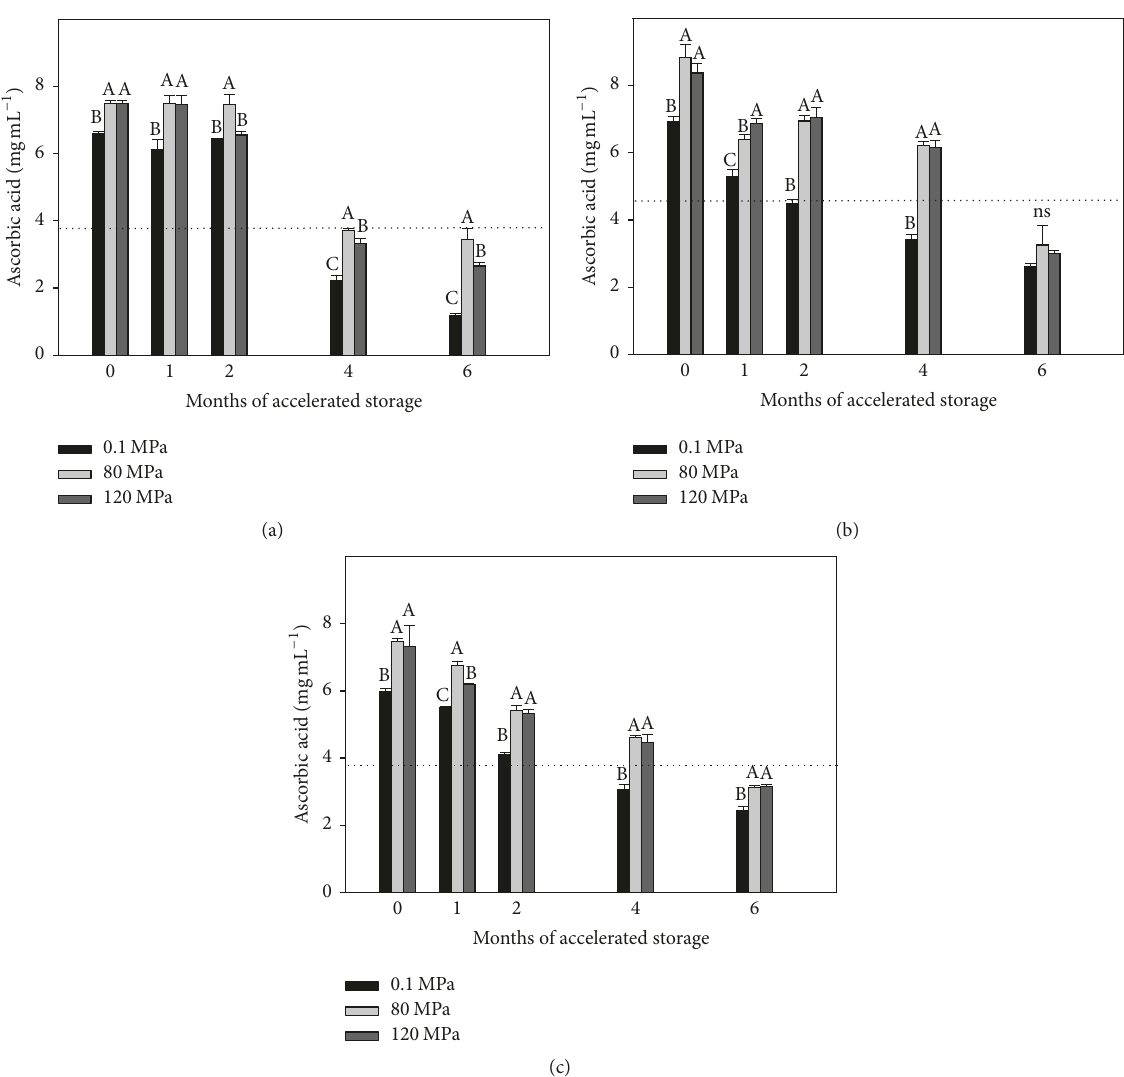
Figure 1: The effect of HPH treatments on the ascorbic acid content of cranberry (a), royal jelly (b), and iron food supplements (c) stored at 40 ∘ C ± 2 ∘ C and 75% ± 5% RH. Mean ( 𝑛 = 3 ± SD). Different letters within the same day indicate significant differences between pasteuriza- tion and HPH treatments at 𝑝 ≤ 0.05 . ns: not significant. The dotted line indicates 50% vitamin losses with respect to the initial contents shown in Table